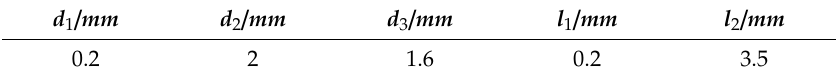
Table 2. Geometric parameters of the heat exchanger (V1) used for parametric study together with baseline values.